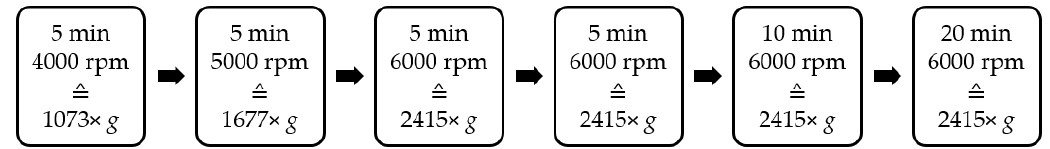
Figure 3. Diagram of the centrifugation test to determine the water holding capacity.